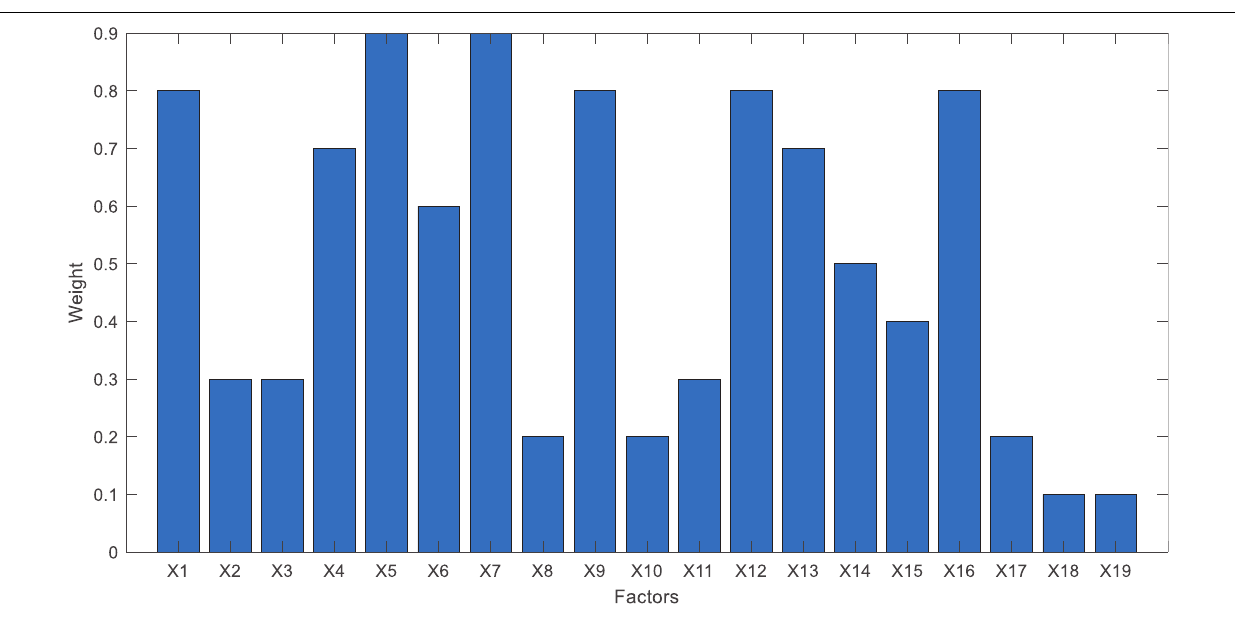
FIGURE 3 | Weight of enterprise social responsibility factor generated by